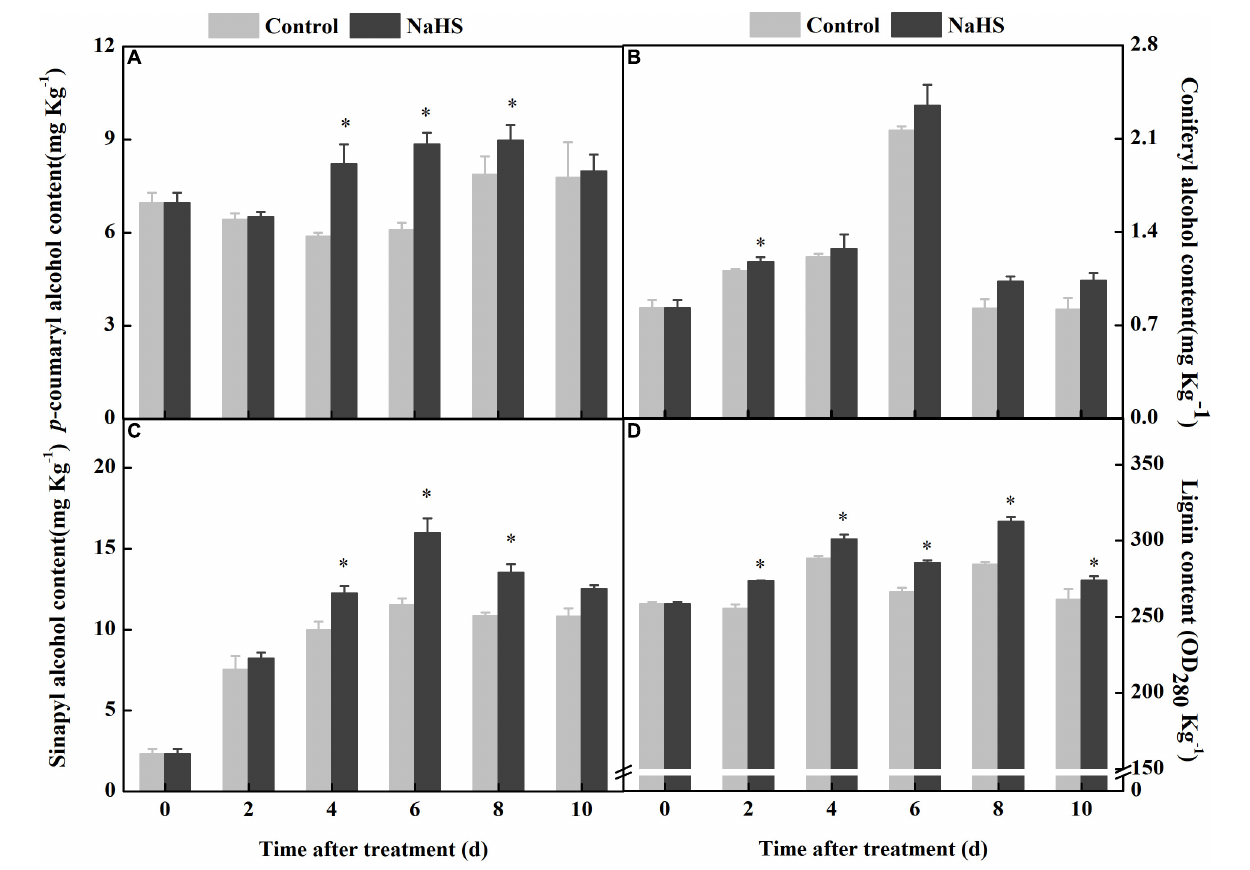
FIGURE 5 | Changes in the content of p- coumaryl alcohol, coniferyl alcohol, sinapyl alcohol, and lignin in apples after NaHS treatment. p- Coumaryl alcohol (A) , coniferyl alcohol (B) , sinapyl alcohol (C) , and lignin (D) . The light gray and black bars represent the control and NaHS treatments, respectively. The bars represent the standard error of the mean ( ± SE). ∗ Significant differences at P <